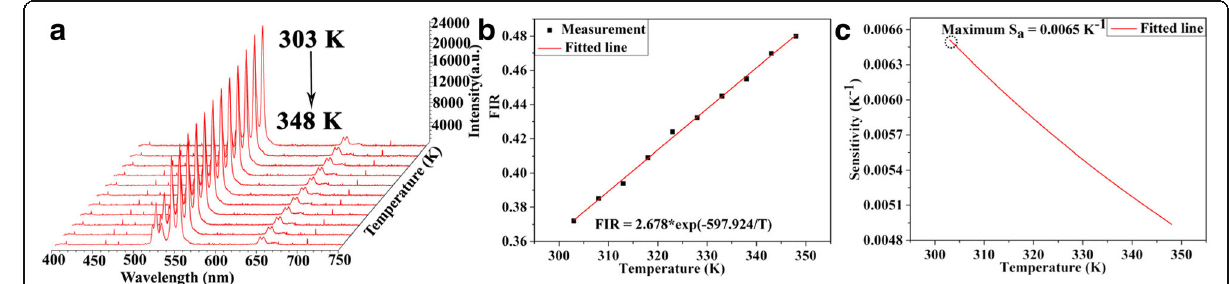
Fig. 10 a 3D up-conversion emission spectra without Ag under 980 nm excitation source. b Fitted curves between fluorescence intensity ratio and temperature without Ag. c Fitted data between sensitivity (K − 1 ) and temperature (K) without